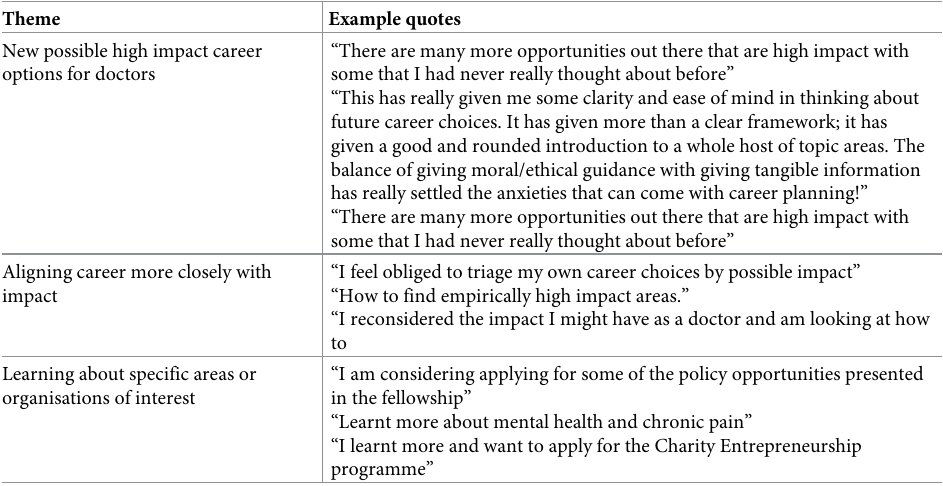
Table 6. Participant responses about their main learnings from the